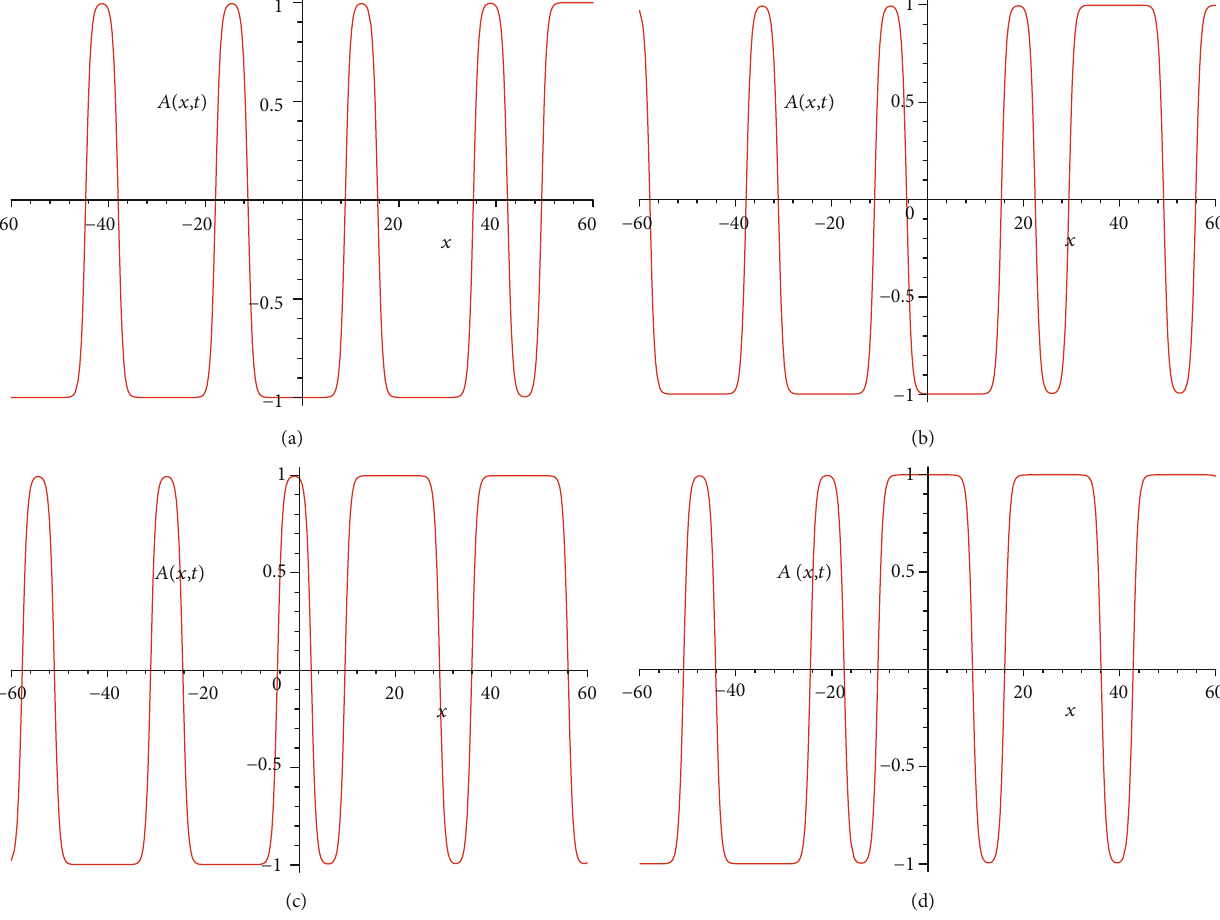
Figure 3: A special interaction solution A in equation (80) with the parameters being selected as equation (81) which exhibits the interaction between soliton and cnoidal wave at (a) t = − 20 , (b) t = − 10 , (c) t = 0 , and (d) t = 10 , respectively.